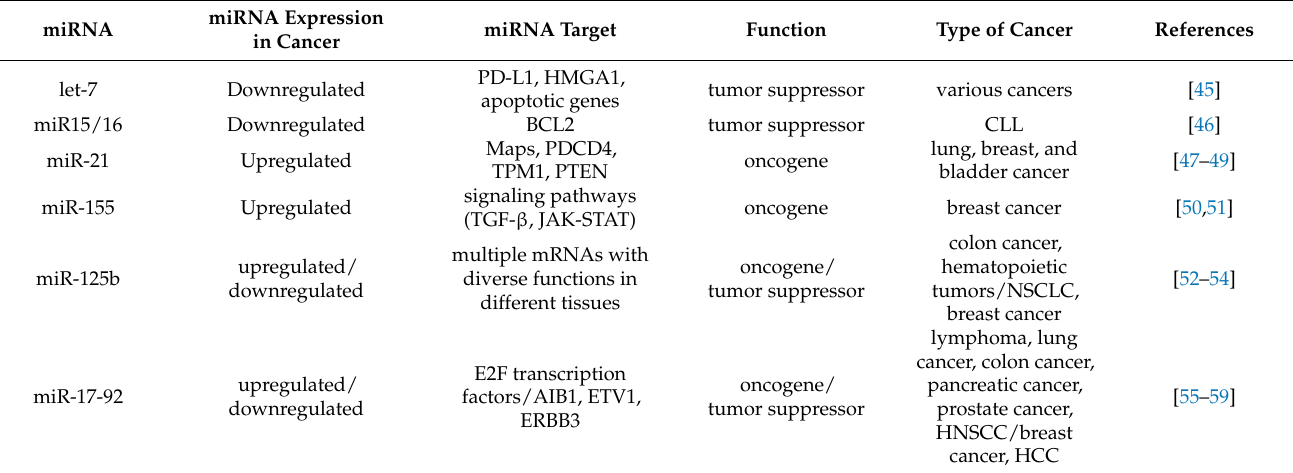
Table 2. Examples of miRNAs as tumor suppressors and oncogenes in